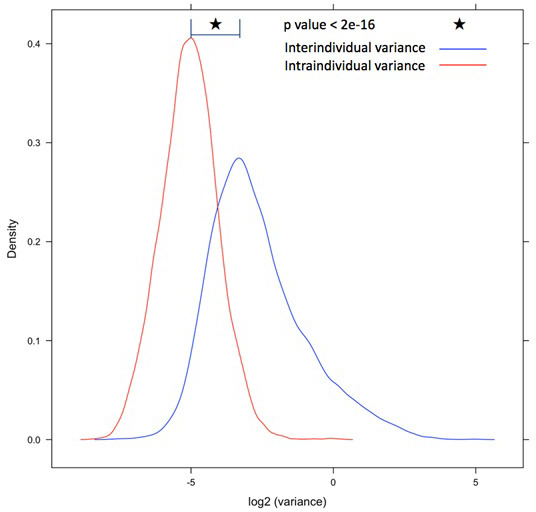
Plot showing distribution of inter vs intra-individual variance.